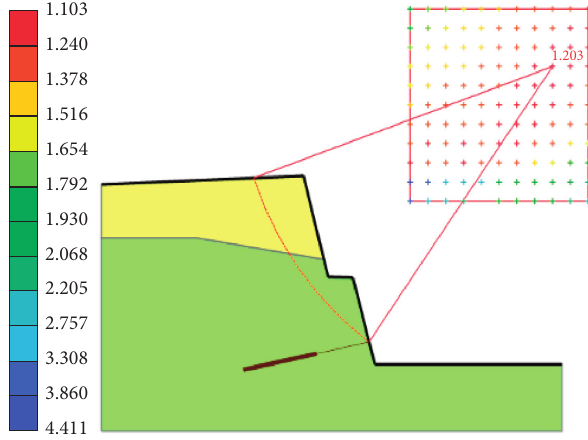
Figure 19: Safety factor after